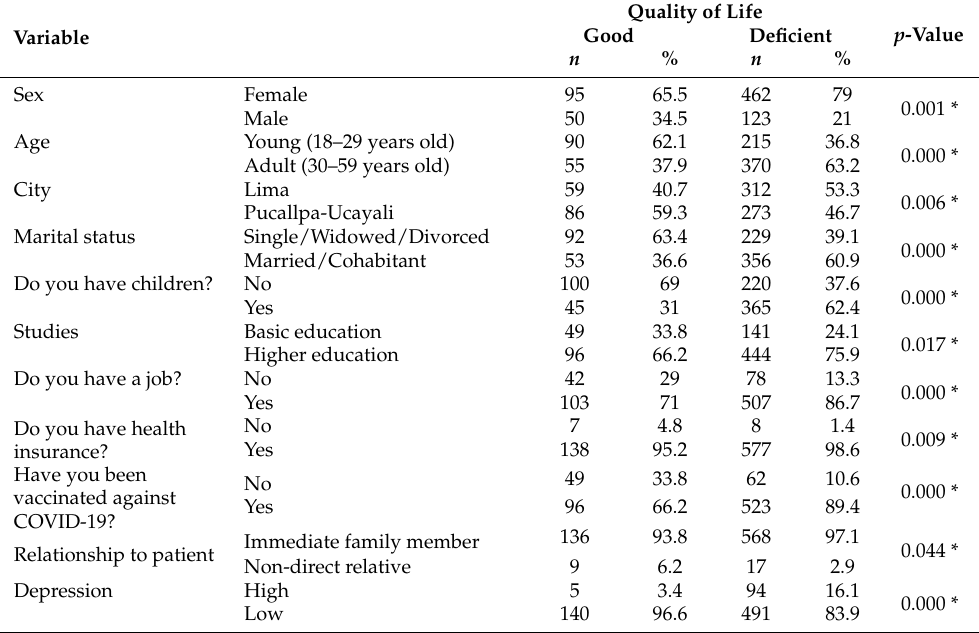
Table 3. Bivariate analysis according to caregiver quality of life post COVID-19.